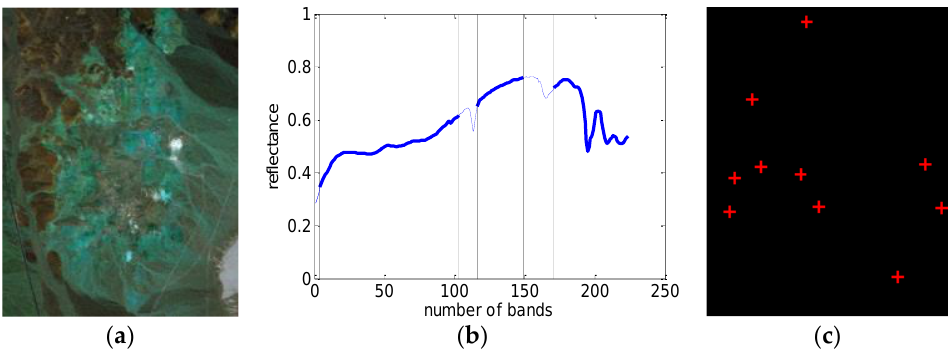
Figure 1. Synthetic data: ( a ) pseudocolor image (Bands 160, 100, and 40 for RGB); ( b ) embedded target spectrum; and ( c ) ground truth.